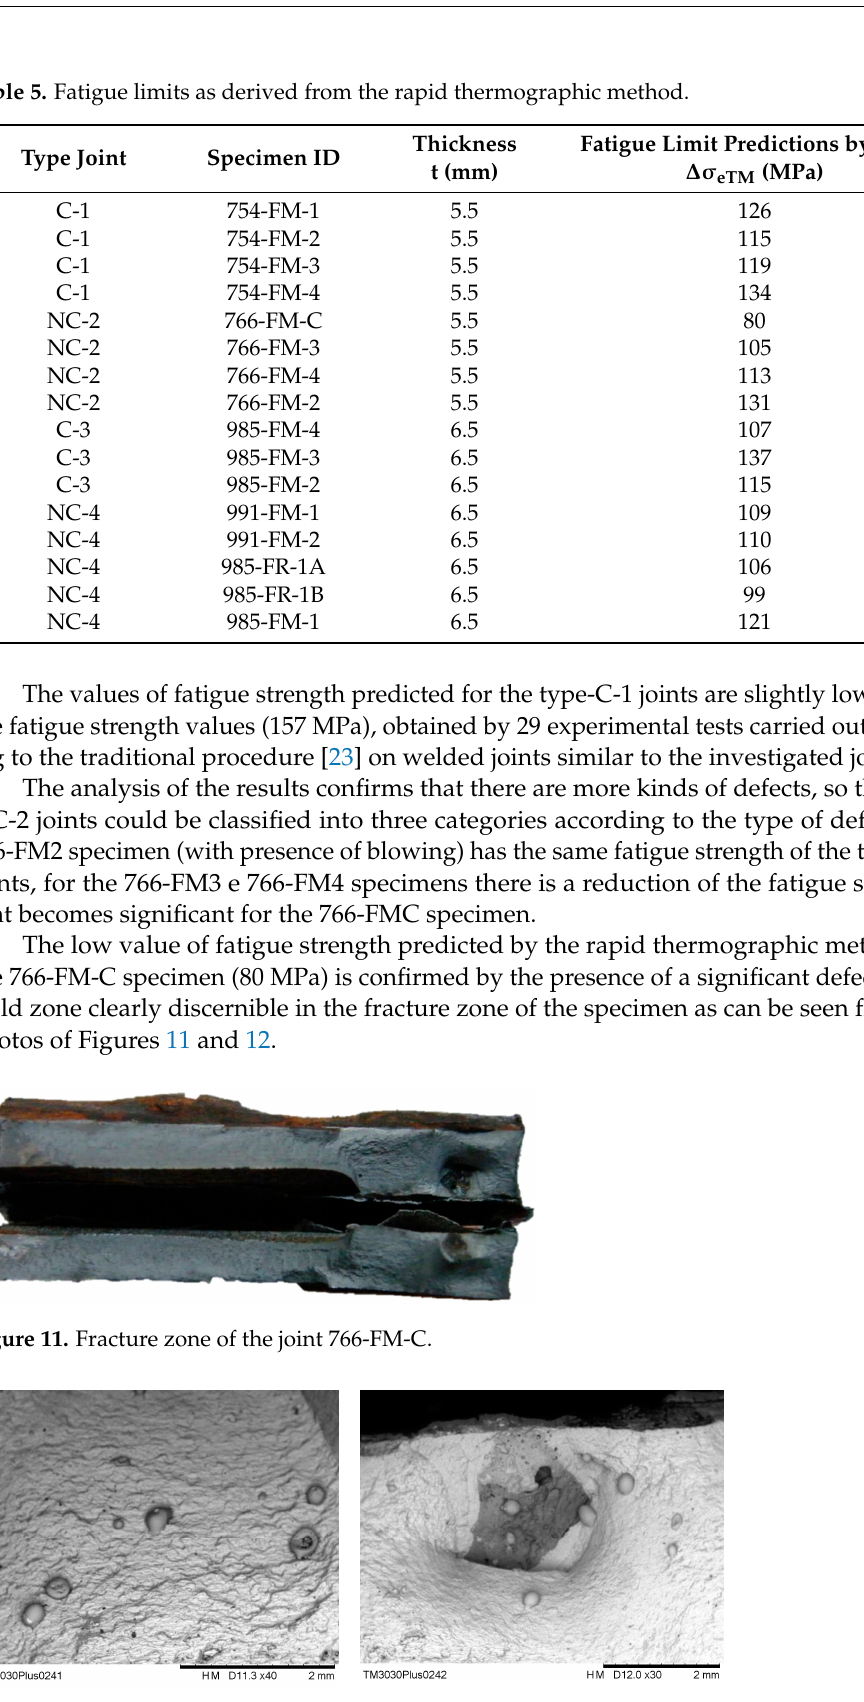
Table 5. Fatigue limits as derived from the rapid thermographic method.